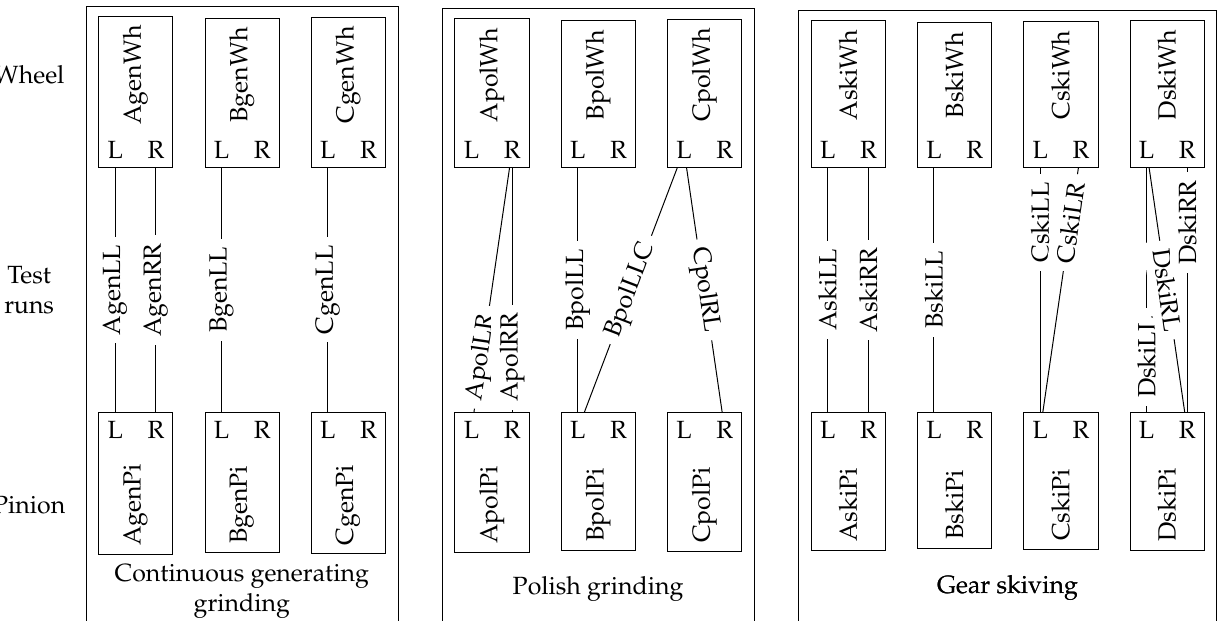
Figure 9. Overview of the active flanks of the gears in the test runs